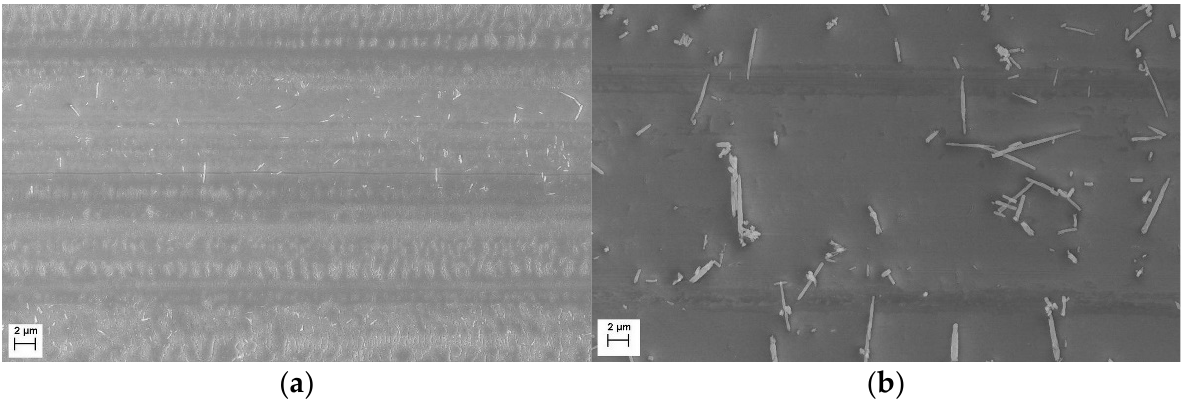
Figure 9. Morphology of the bottom of the wear track on samples TaN3 ( a ) and TaAlN3 ( b ).